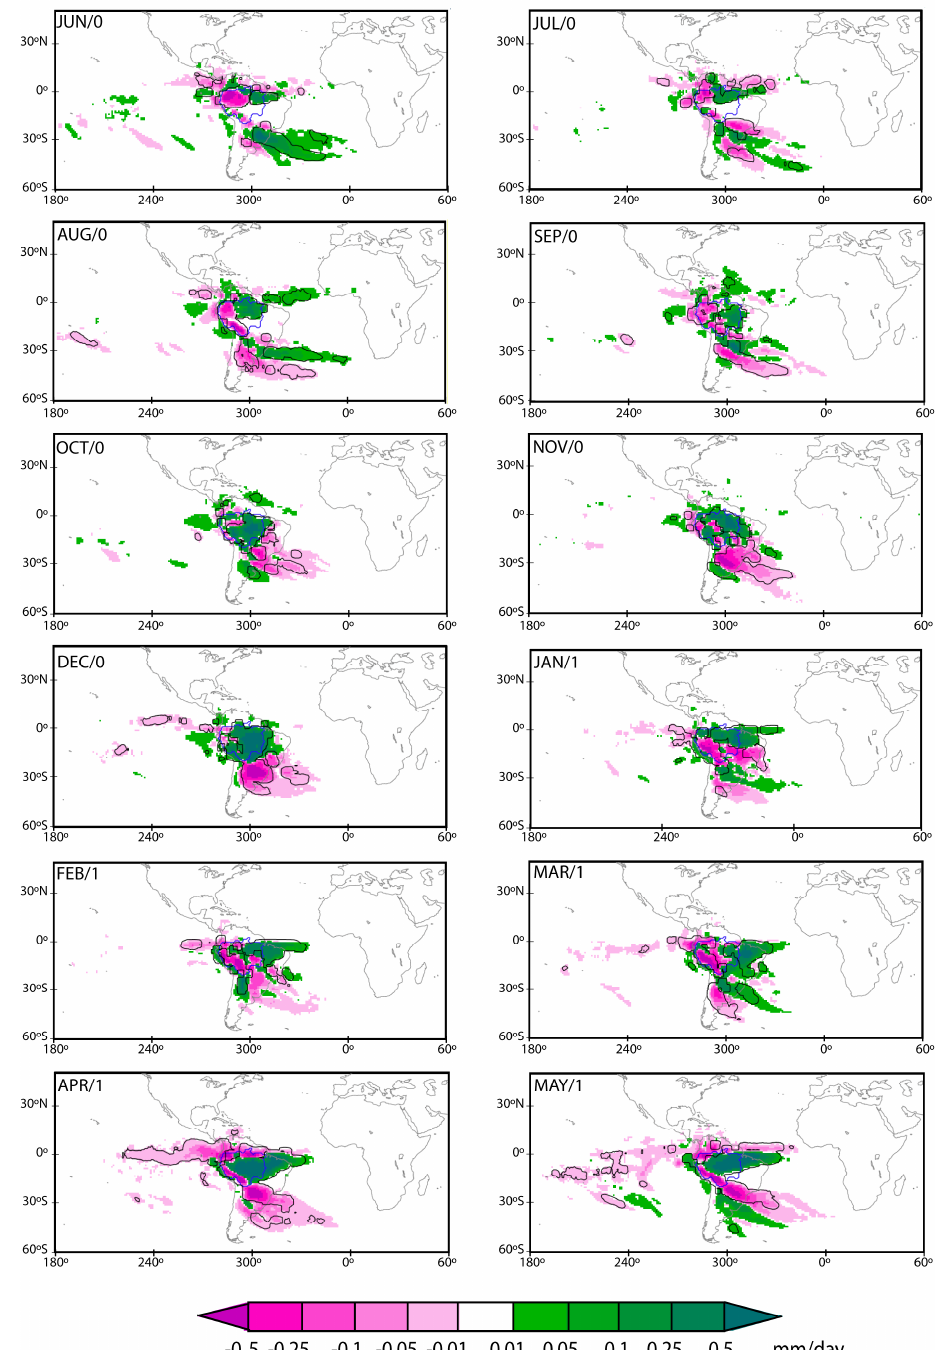
Figure 8 1 Figure 8. As Fig. 6, but for extreme AMM episodes. Pink (green) colours in the left-hand column indicate regions where the sinks are more